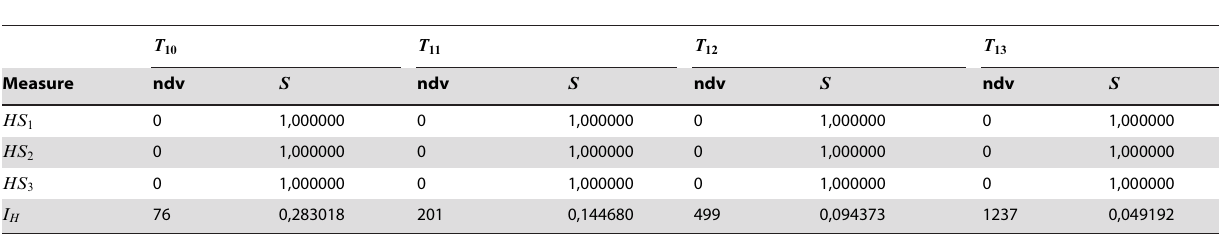
Table 1. Exhaustively generated sets of non-isomorphic trees: D T 10 D ~ 106 , D T 11 D ~ 235 , D T 12 D ~ 551 , D T 13 D ~ 1301